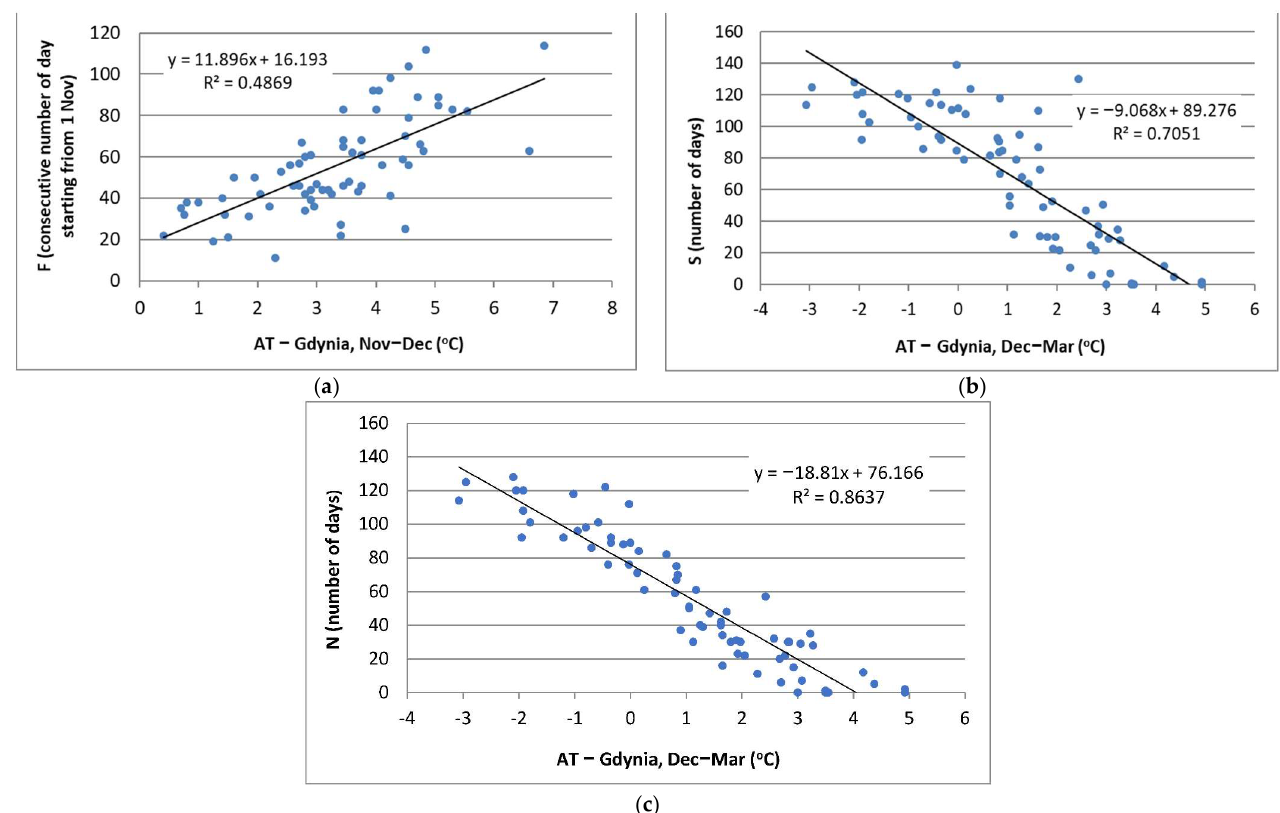
Figure 7. Correlations between: ( a ) date of first ice occurrence (F); ( b ) ice season duration (S); ( c ) the number of days with ice (N) on Puck Lagoon, and air temperature (AT) from selected periods (Nov–Dec, Dec–Mar), along with the regression line and determination coefficient R 2 . AT data span 1950/51–2019/20.